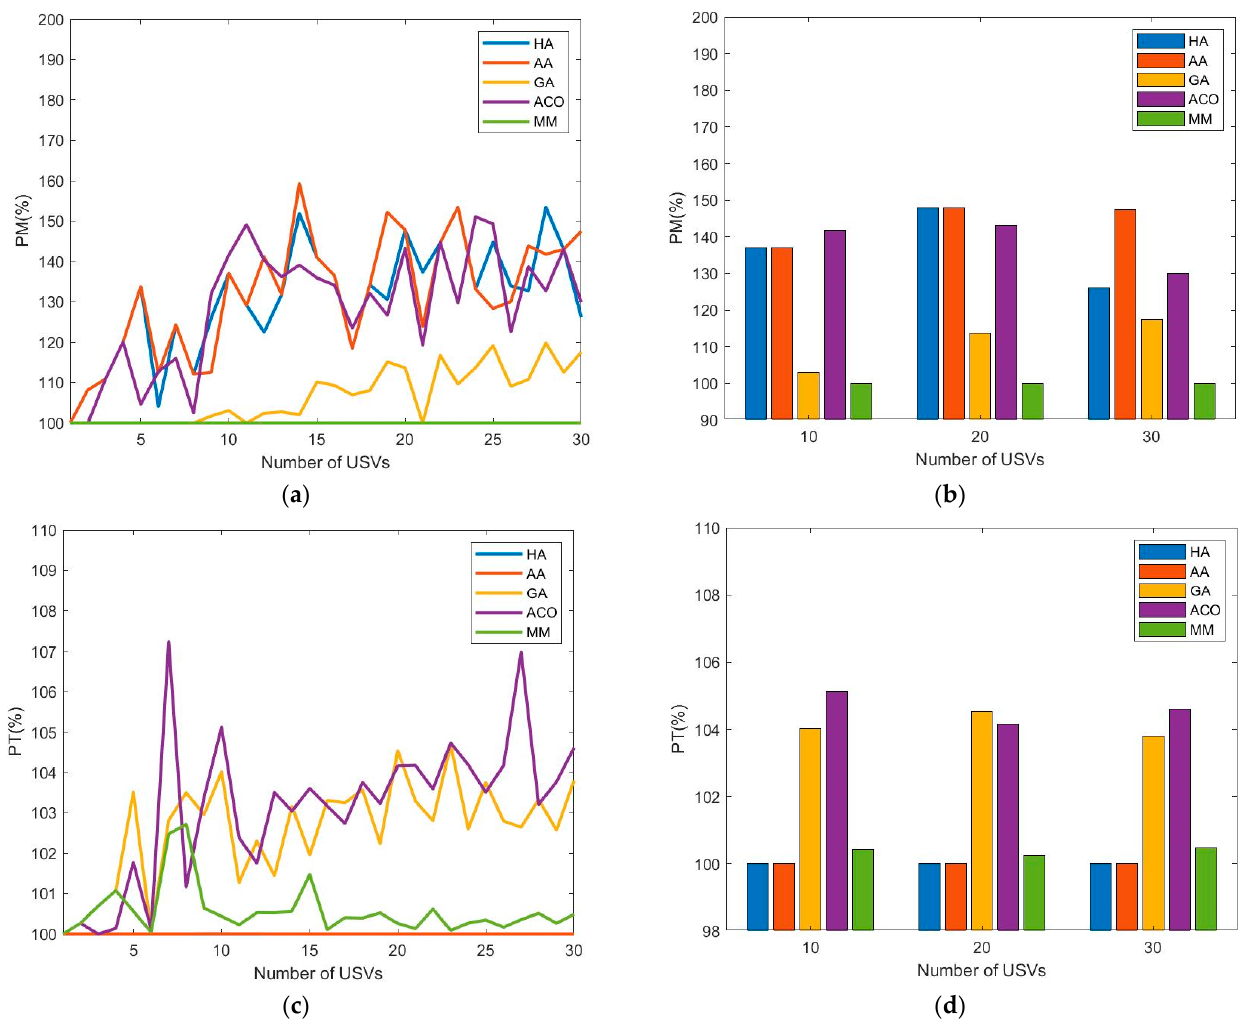
Figure 2. Comparison of algorithms in the max cost and the total cost. ( a ) PM of the algorithms with the number of USVs from 1 to 30. ( b ) PT of the algorithms with the number of USVs from 1 to 30. ( c ) PM of the algorithms where the number of USVs were 10, 20 and 30. ( d ) PT of the algorithms where the number of USVs were 10, 20 and